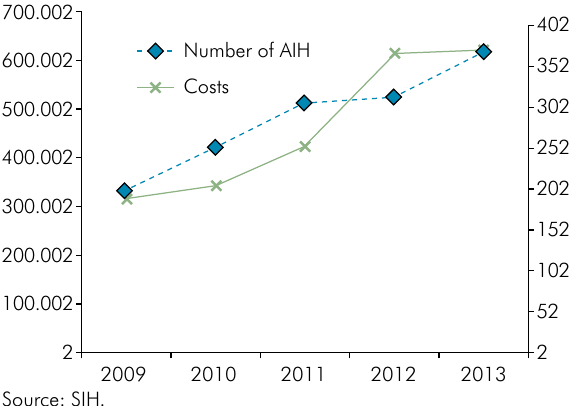
Figure 4. Number of Authorization Forms for Hospital Admittance and costs for surgical procedures for orofacial clefts in Brazil, between 2009 and 2013.